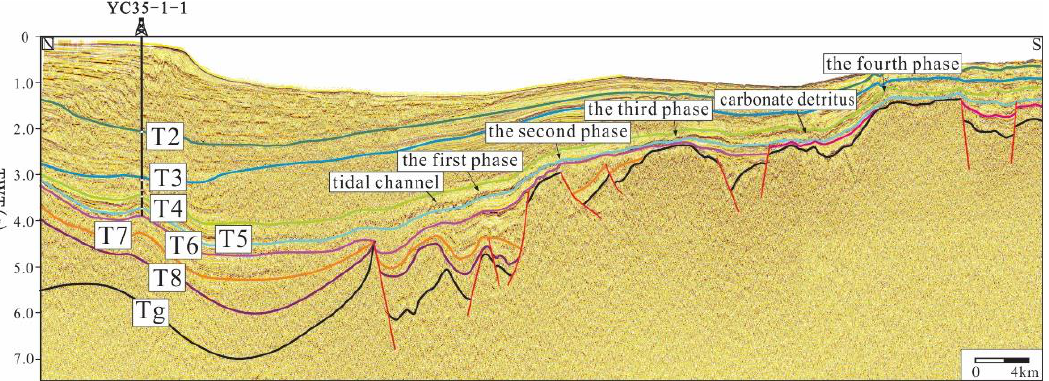
Figure 3. Seismic profile across Well YC35-1-1 in the Xisha sea area. The profile location is shown in Figure 1B .